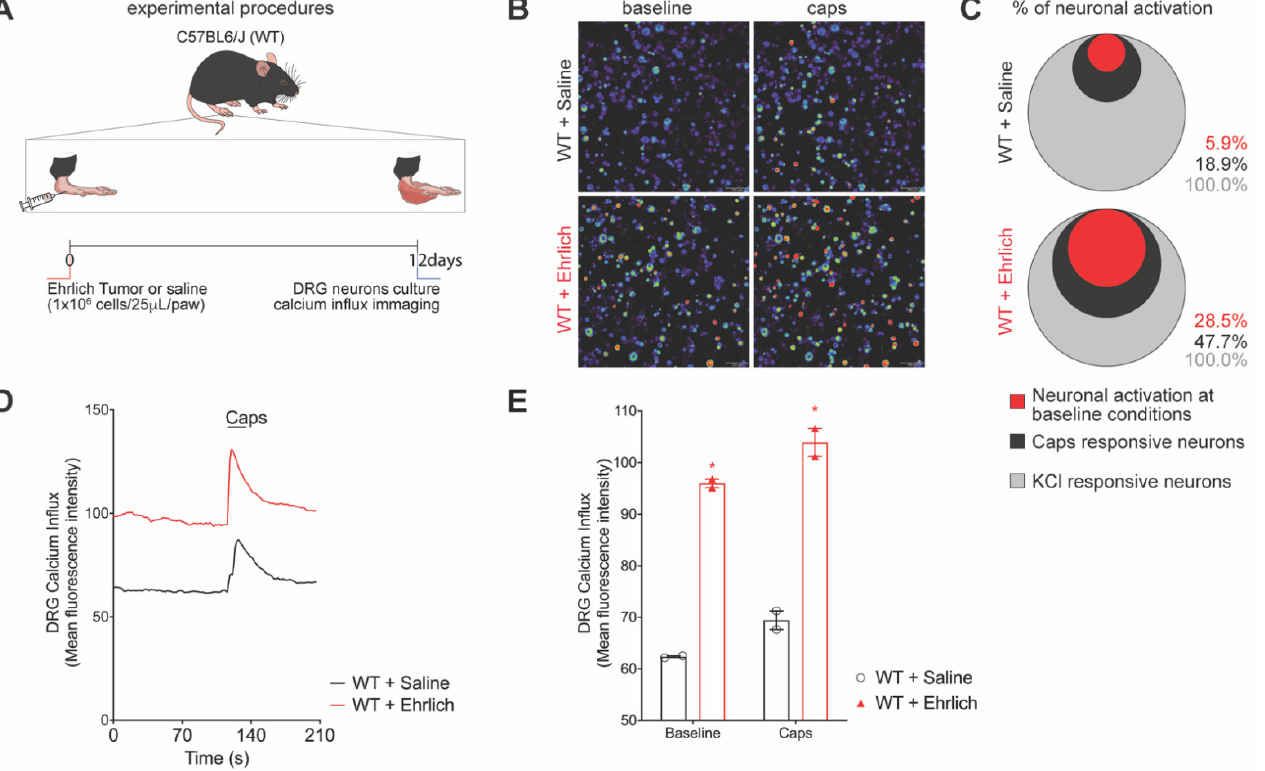
Figure 1. DRG neurons from Ehrlich tumor-stimulated mice presented with high basal activation and enhanced response to capsaicin, a TRPV1 agonist. ( A ) Experimental design scheme. C57Bl/6 mice received an intraplantar injection of Ehrlich tumor cells (10 6 , 25 µL paw) or saline in the control group and 12 days after the DRGs (L4–L6) were collected and cultured. ( B ) Representative fields of baseline fluorescence of DRG neurons dissected from saline and Ehrlich tumor cells-stimulated mice and representative fields after capsaicin plate stimulation (1 µ M per plate). ( C ) Venn Diagram comparing the neurons population with increased baseline activation that had responded to capsaicin stimulation. ( D ) Tracers of mean fluorescence intensity of calcium influx of the baseline (0-s mark) and following capsaicin stimulation (120 s mark, TRPV1 agonist). The black line refers to the Saline-stimulated DRGs, and the red line refers to the Ehrlich tumor cells-stimulated DRGs. ( E ) Quantification of mean fluorescence intensity of calcium influx of baseline (0-s mark) and following the stimulus with capsaicin (120-s mark). n = 2 DRG culture plates per group per experiment. Each plate is a neuronal culture pooled from 10 mice. Two independent experiments were performed, and plotted data are the mean of both experiments. Results are expressed as median + range. (* p < 0.05 vs. saline). Statistical information can be found at Table